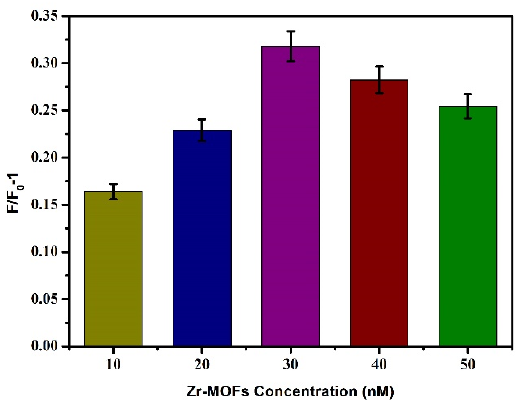
Figure 5. Effects of different concentrations of Zr-MOFs on fluorescence intensity.